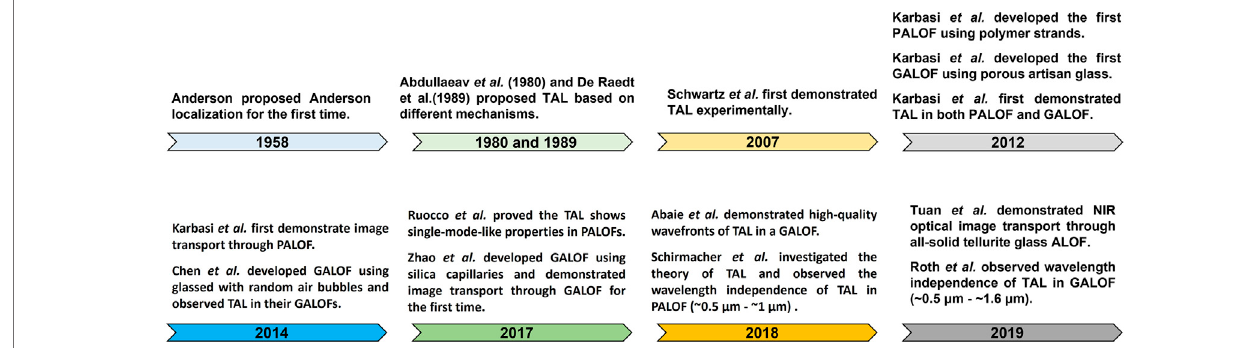
FIGURE 2 | Historical overview of ALOF developments.